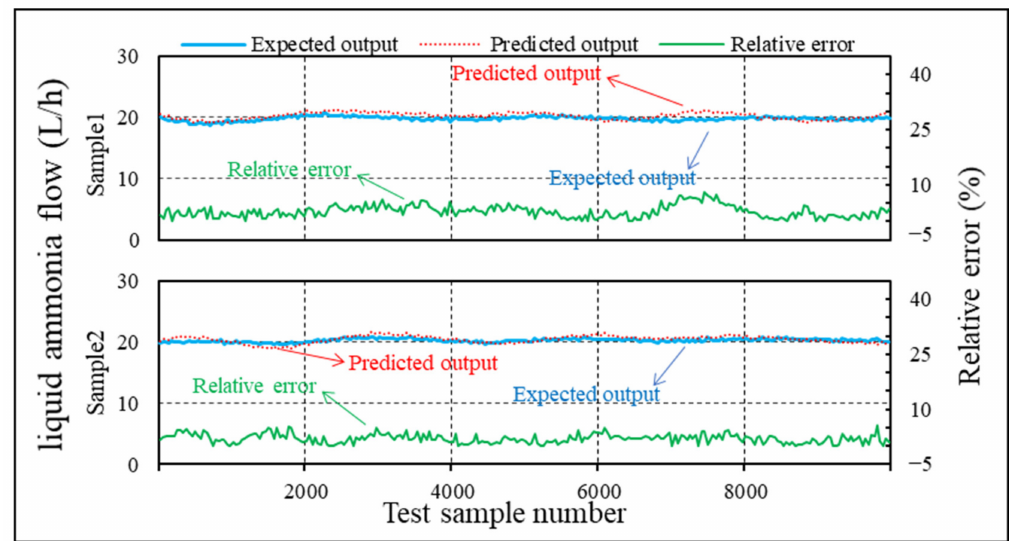
Figure 8. Predicted liquid ammonia flow by BPNN.